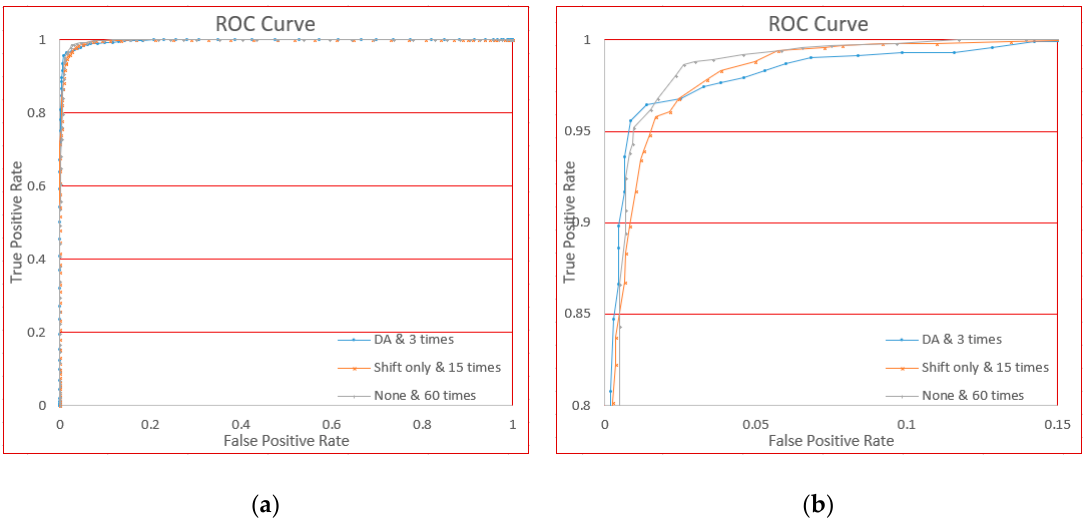
Figure 19. The ROC curve of using or not using data augmentation. ( a ) Is the global view and ( b ) is the local view for clarity.